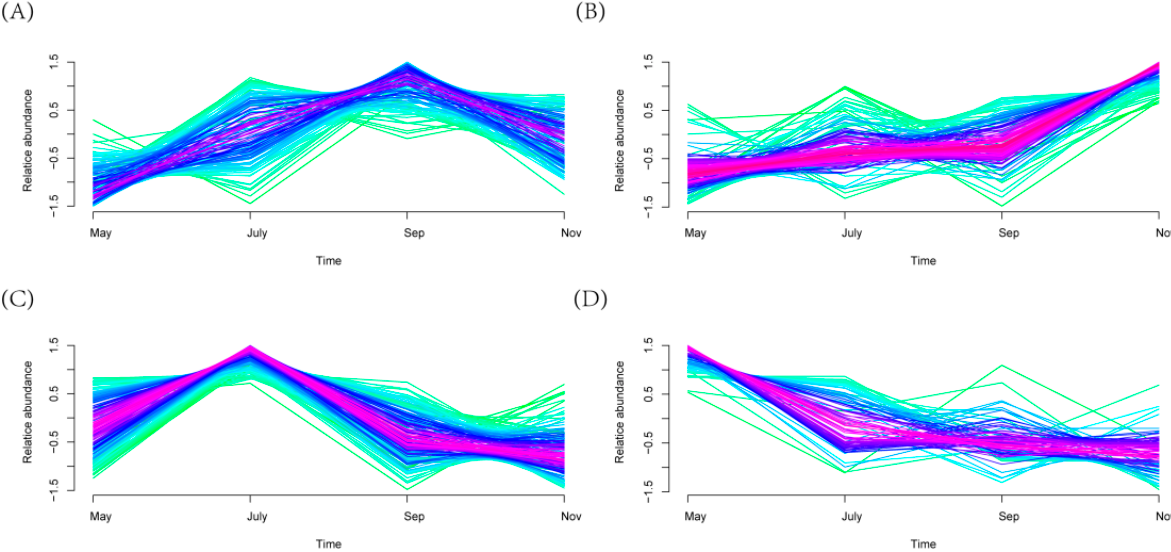
Figure 7. Clustering results of Cluster ( A ) 1, ( B ) 2, ( C ) 3 and ( D ) 4. Red shades indicate high membership values and green shades low membership values of bacterial.